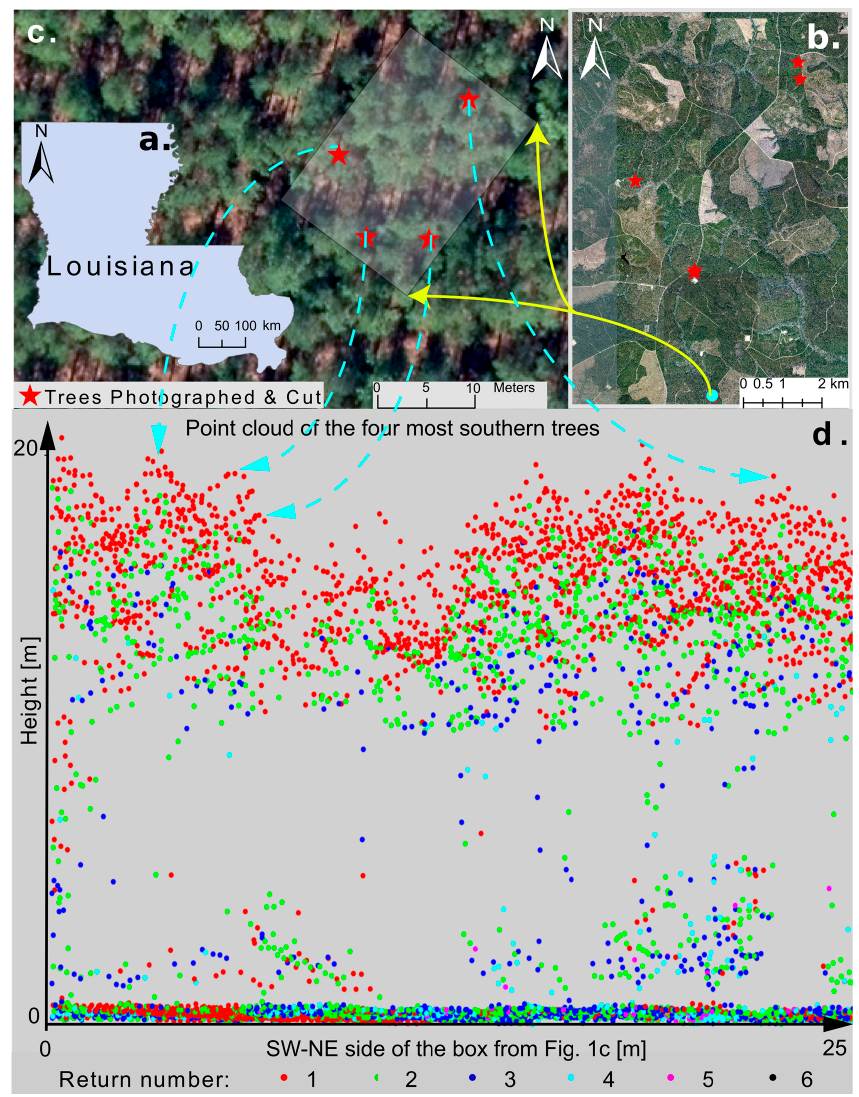
Figure 1. Area showing the location of the trees: ( a ) general position of the trees within Louisiana; ( b ) locations of all the trees photographed and cut; ( c ) the four most southern trees. The yellow arrows show the size of a rectangular box (highlighted) containing the southern four trees; ( d ) lidar point cloud of the rectangle containing the southern four trees from ( c ). The arrows from ( c ) to ( d ) indicate the top of each tree in the point cloud.